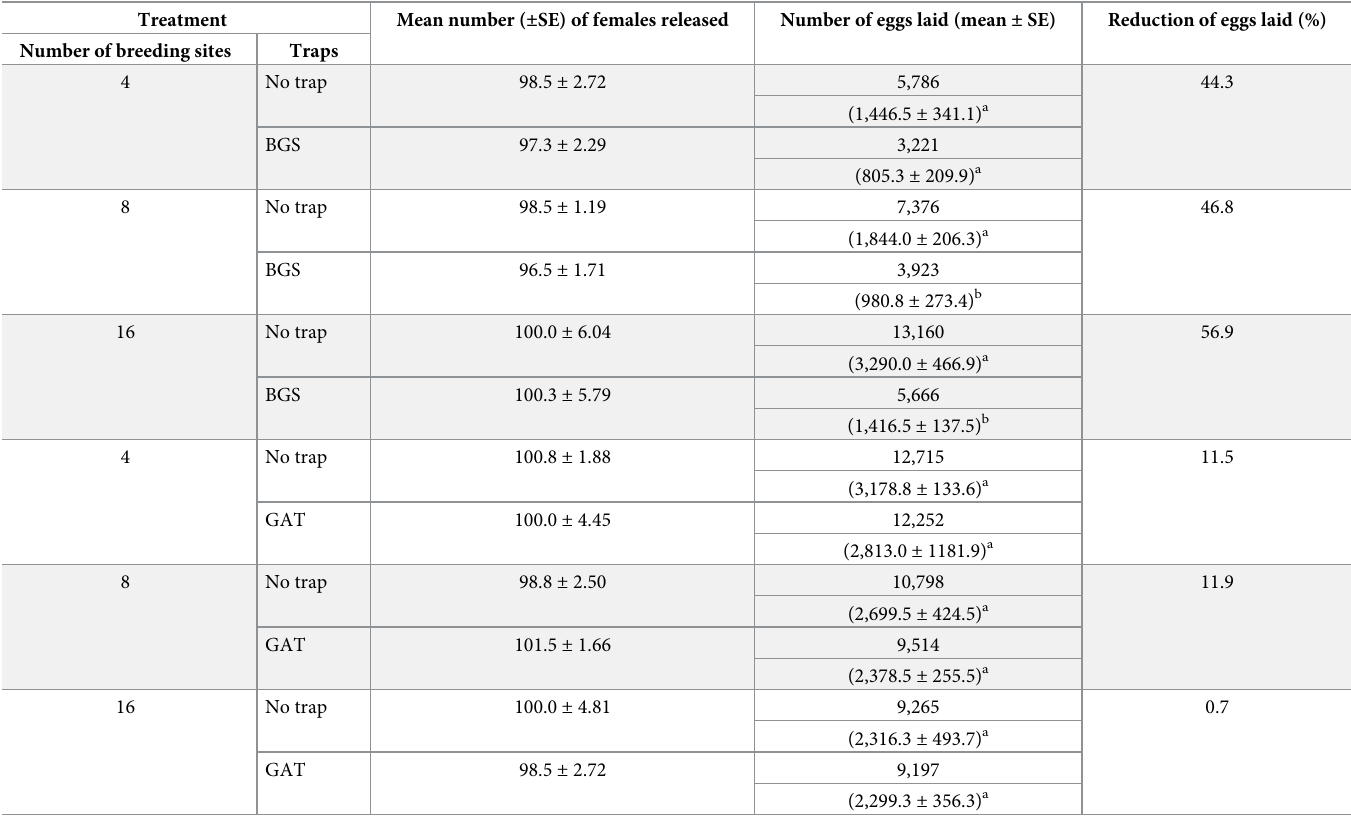
Different letters indicate significant difference between each treatment group with and without traps (p <